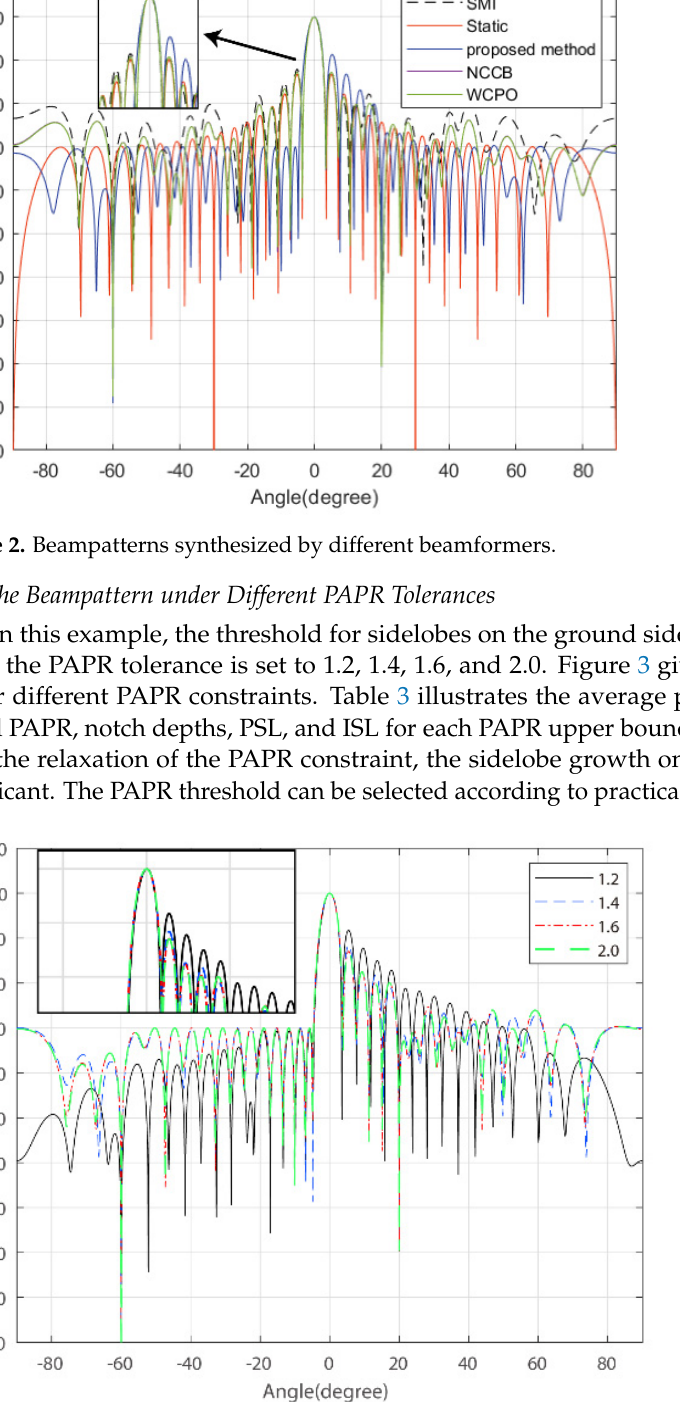
Figure 2. Beampatterns synthesized by different beamformers.